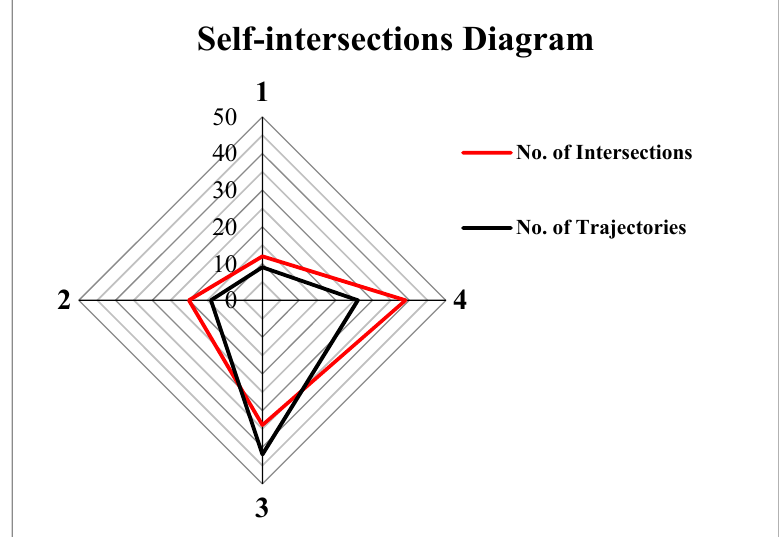
Figure 17. Trajectory self-intersection diagram.